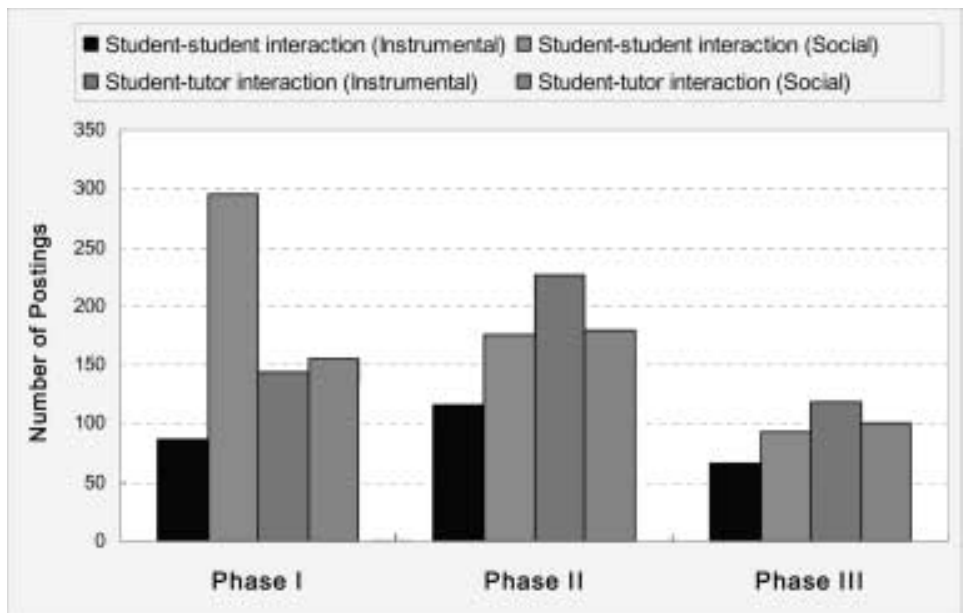
Figure 2. Summary of student–student and student–tutor postings for instrumental and social reasons over the three identified phases (weeks